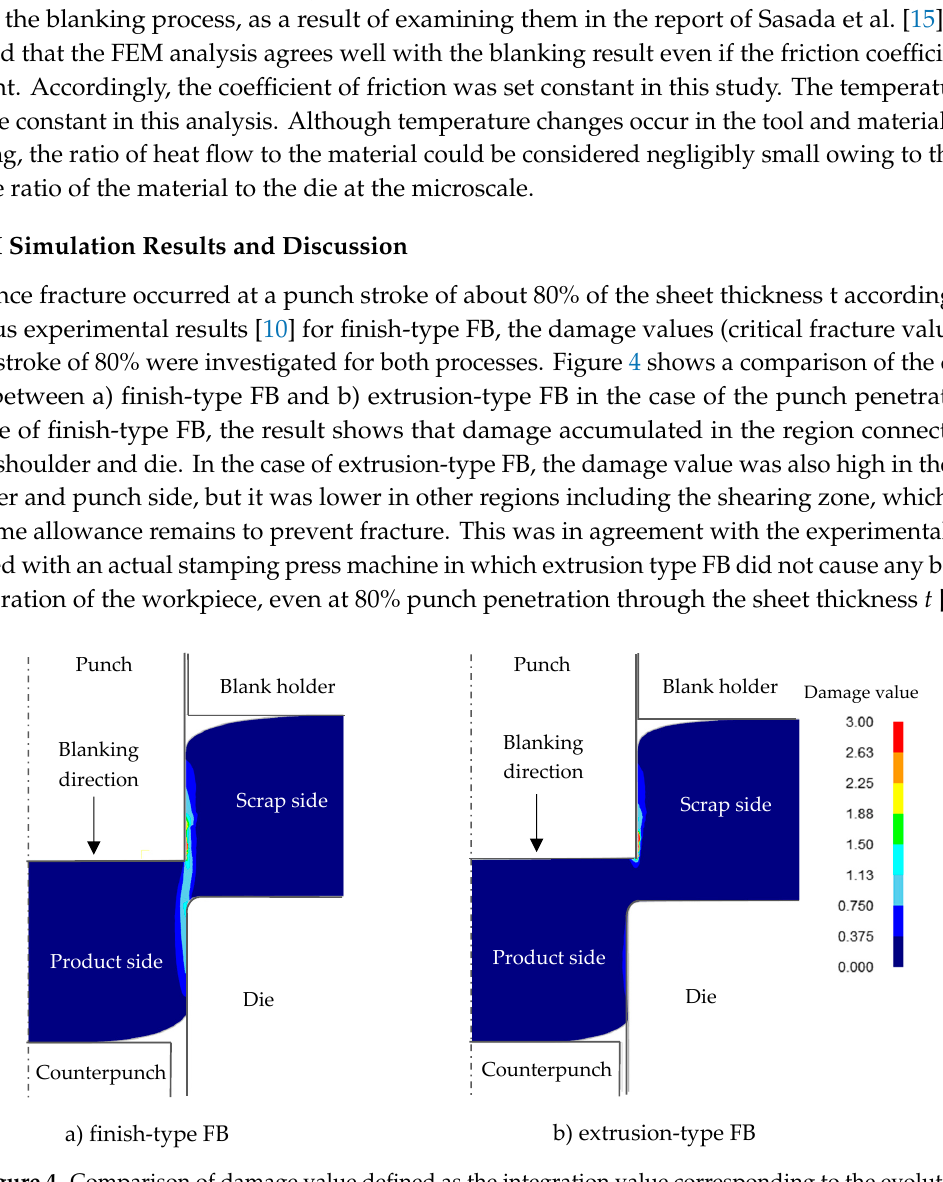
Figure 3. Flow stress-plastic strain curve. Table 1. FEM simulation conditions.